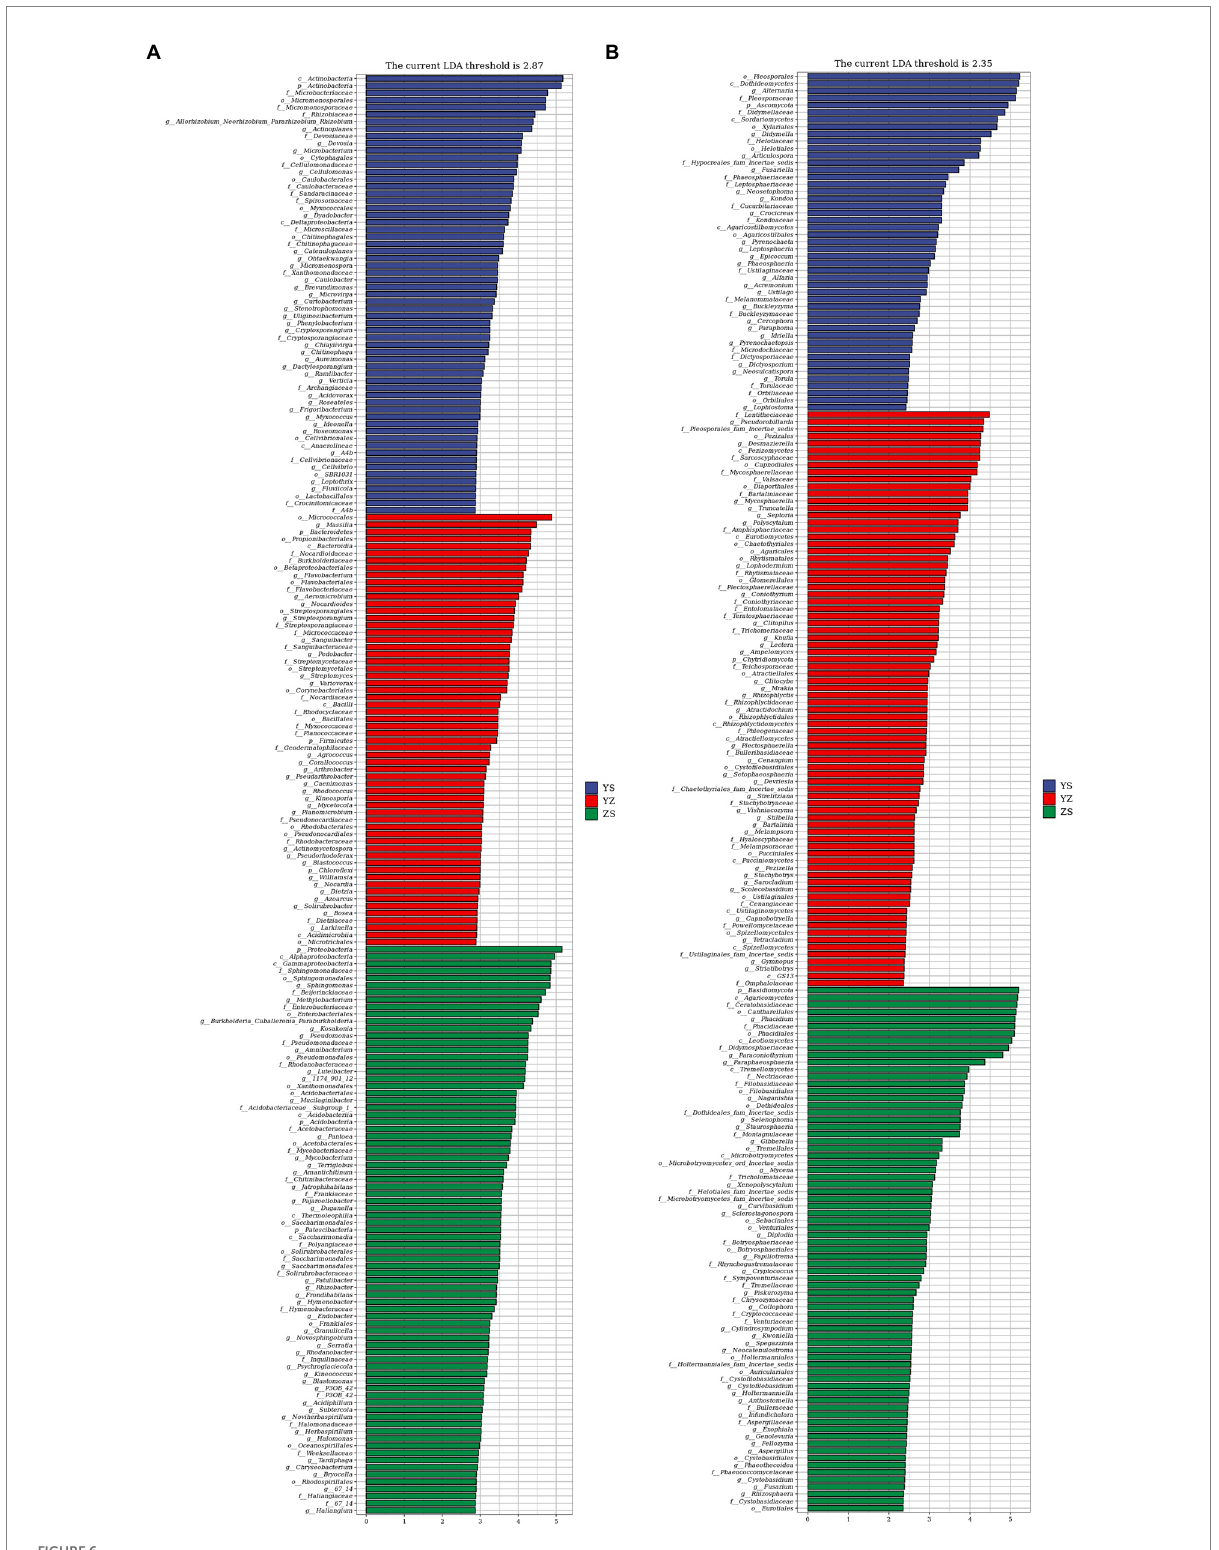
FIGURE 6 Microbial community of different leaf litter ratios with significantly different taxa. (A) litter bacterial communities; (B) litter fungal communities. YS: Populus × canadensis Moench; YZ: Populus × canadensis Moench- Pinus sylvestris var. mongolica ; ZS: Pinus sylvestris var. mongolica. The longer the length, the more significant the difference between the taxon units, and the different color of the bar chart indicates the higher abundance sample group corresponding to the